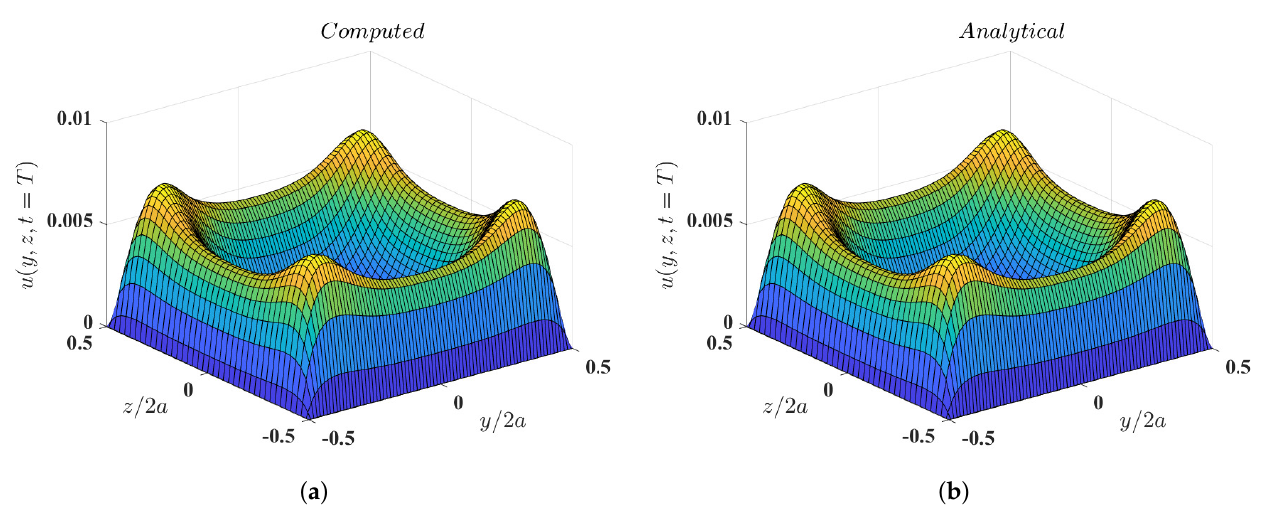
Figure 5. Distribution of the velocity field across the y − z plane of the pulsatile flow through a square duct with the Womersley number Wo = 6.25 at the instant t = T ( a ) computed using 3DCCM-LBM with aspect ratios of ( r , s ) = ( 0.5,1.0 ) and ( b ) obtained from the exact solution given in Equation (77)